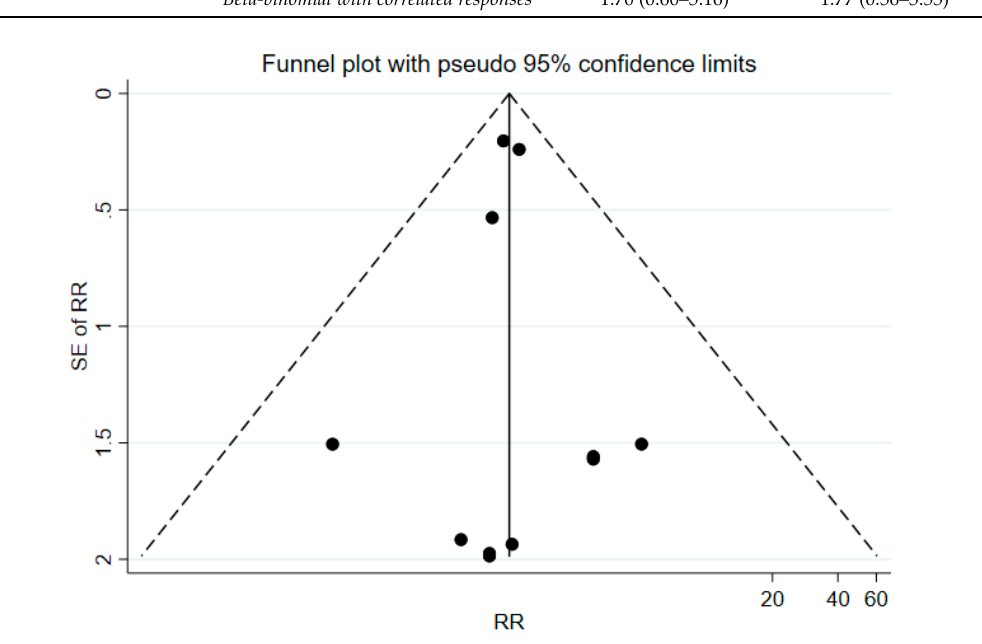
Figure A1. Funnel plot for publication bias evaluation .